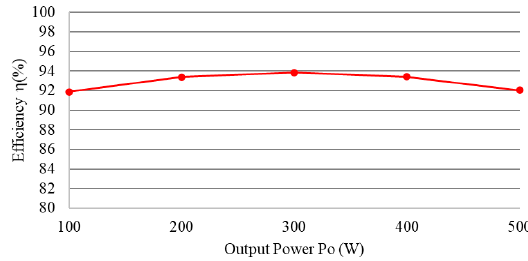
Figure 24. Efficiency curve in step-down mode.